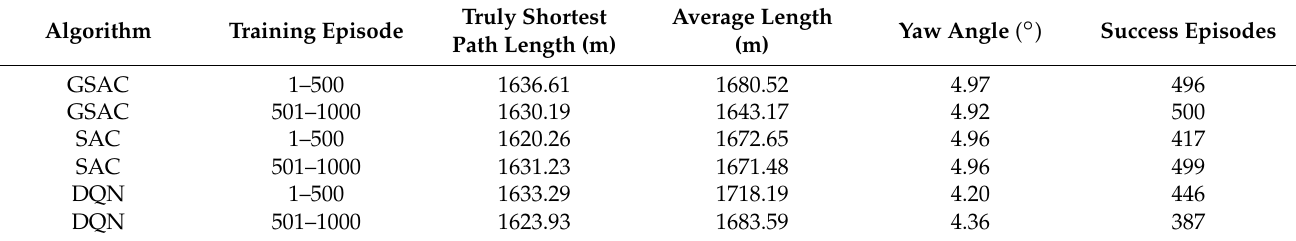
Table 4. Static environment simulation